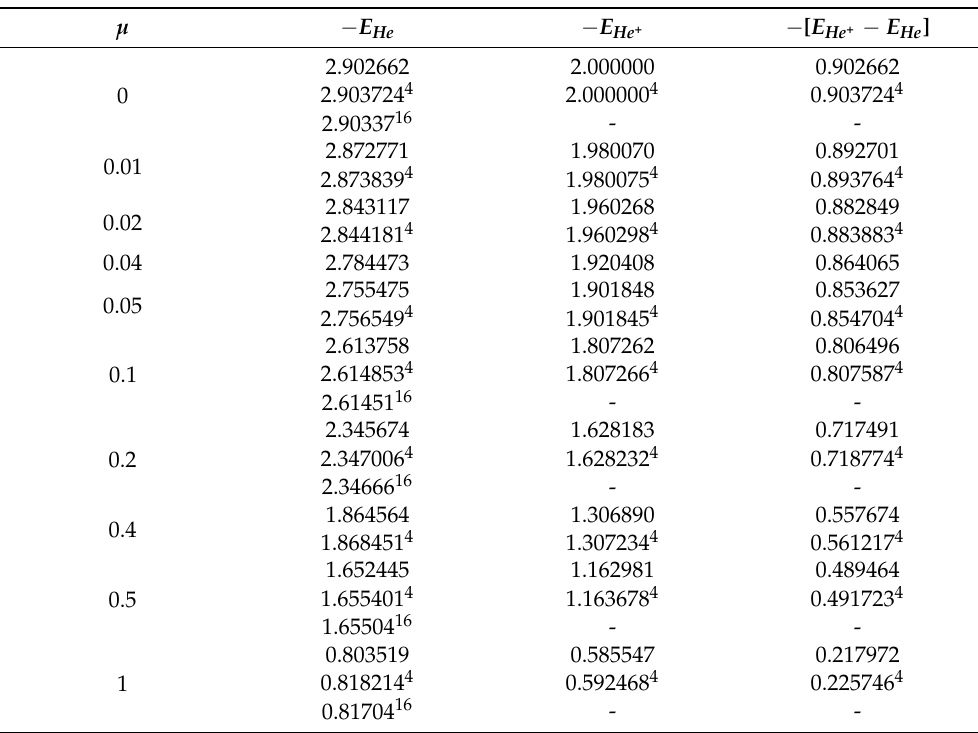
Table 1. Ground state energies of the helium atom under effective SCP in dense quantum plasma. The He + threshold energies and ionization potential [ E He + − E He ] of He are also given.